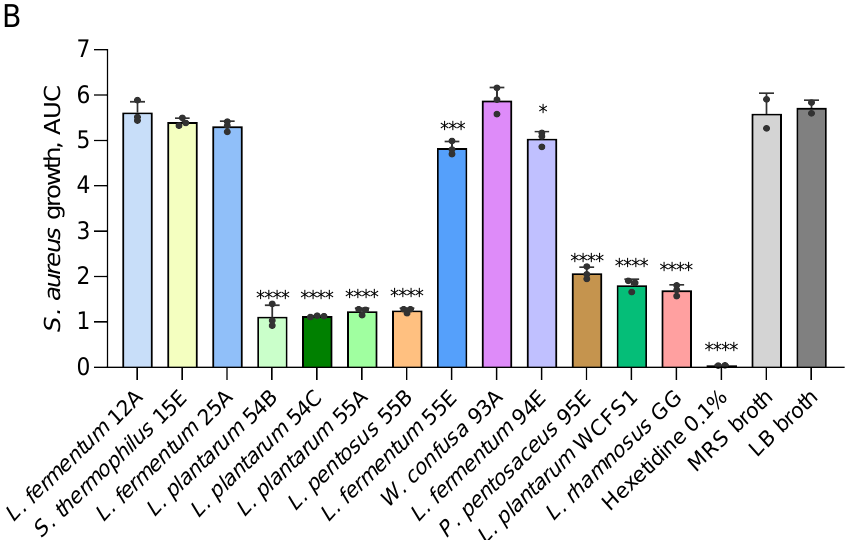
Figure 3. Effect of the LAB strains cell-free culture supernatant (CFS) against the growth of S. aureus MI/1310/1938 in LB broth: ( A ) Growth curves of S. aureus over the course of 24 h, non-inoculated MRS and LB broth and 0.1% hexetidine were used as negative and positive control, respectively. Curves of the most active four LAB strains ( L. plantarum 54B, 54C, 55A, and L. pentosus 55B) are below the curves for the model probiotics ( L. rhamnosus GG and L. plantarum WCFS1), indicating isolates were strong inhibitors. Curves for 95E and model probiotics are overlapping since 95E showed comparable inhibitory activity against the pathogen as model probiotics. ( B ) Area under the curve (AUC) of S. aureus growth curves. Bars depict AUC means ± SD per condition ( n = 3). 55E and 94E have large AUC since they are weak inhibitors. * p < 0.05, *** p < 0.001, **** p < 0.0001 compared to S. aureus grown with MRS broth control. L. plantarum , Lactiplantibacillus plantarum ; L. pentosus